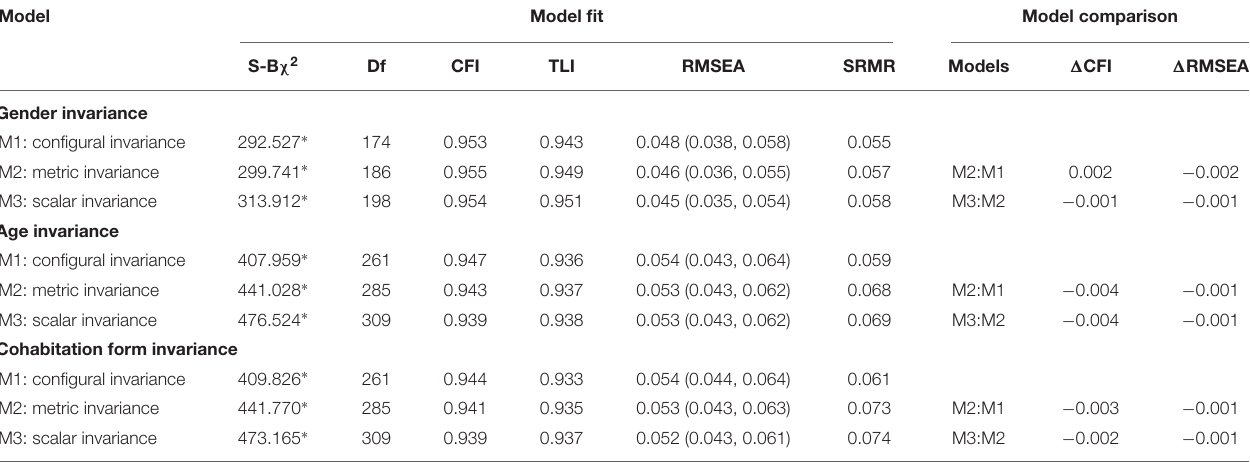
TABLE 5 | Testing measurement invariance of gender, age, and cohabitation form ( n = 585). Model